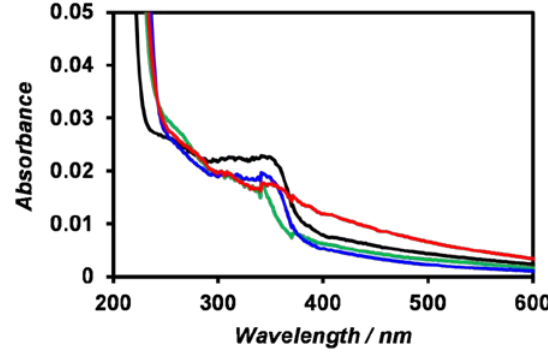
Figure 3. UV-Vis spectra of (black) ZnO nanoparticles, (blue) a mixture of ZnO nanoparticles and peptide 1 , (red) a mixture of ZnO nanoparticles and peptide 2 , and (green) a mixture of ZnO nanoparticles and peptide 3 at [ZnO] = 0.1 mM and [peptide] = 0.1 mM in 10 mM Tris-HCl buffer (pH 7.4) at 25 °C.